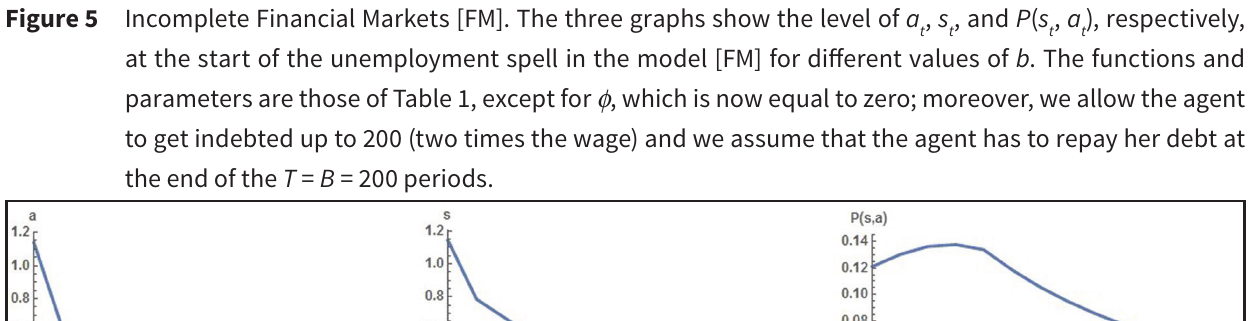
, s , and P ( s , a ), respectively, t t t t